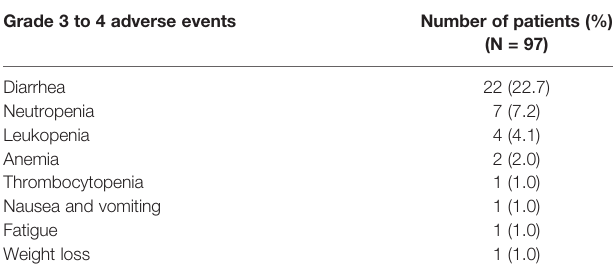
TABLE 5 | Grade 3 to 4 adverse